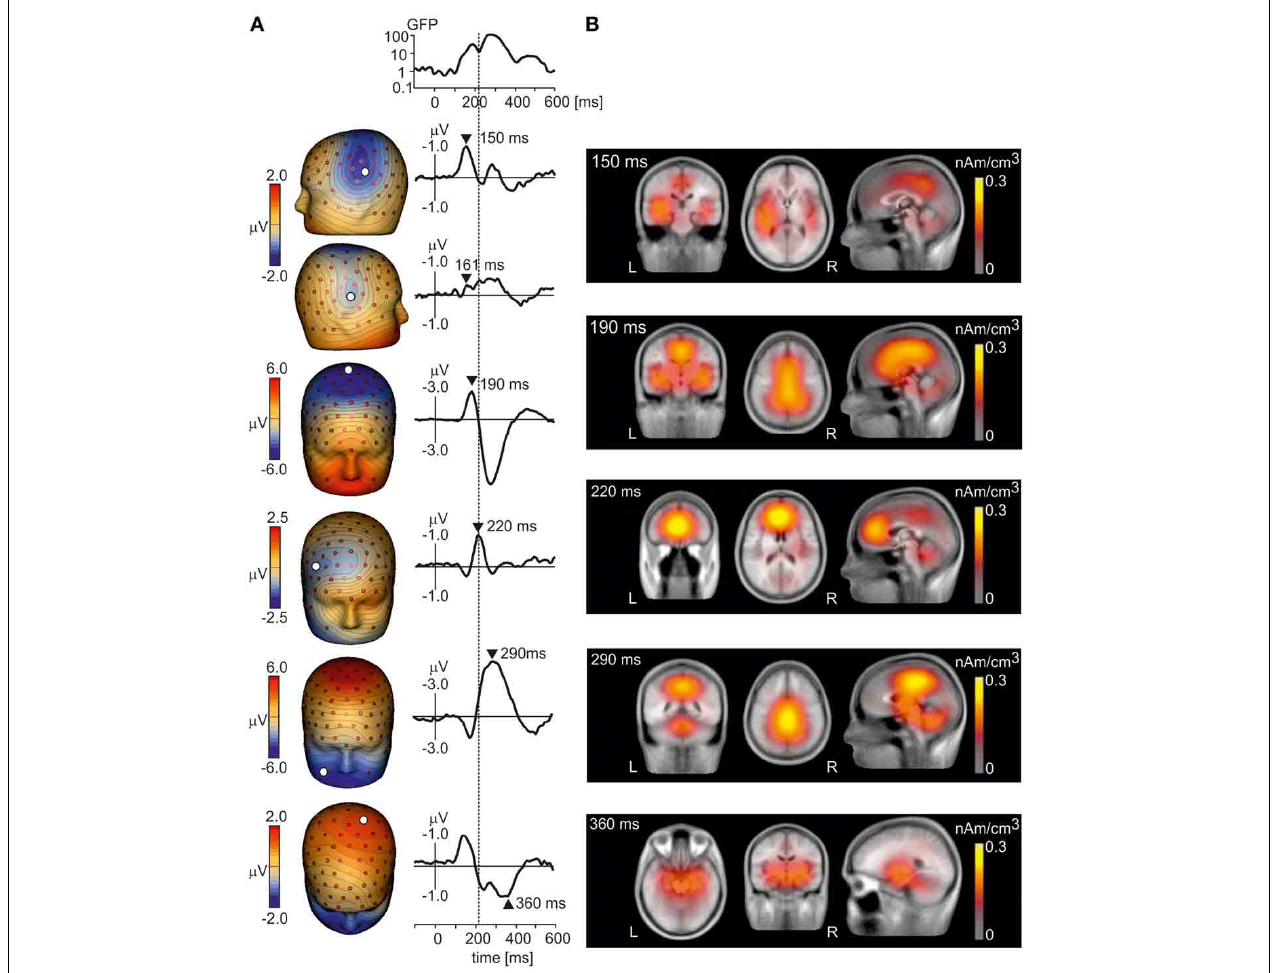
FIGURE 1 | (A) The isopotential maps and potentials at select electrodes of grand average LEPs at six time points: 150ms (N1 potential, top row), 161ms, 190ms (N2 potential), 220ms (N220 potential), 290ms (N3 potential), and 360ms (P3 potential, bottom panel). The global field power is also shown. The vertical line